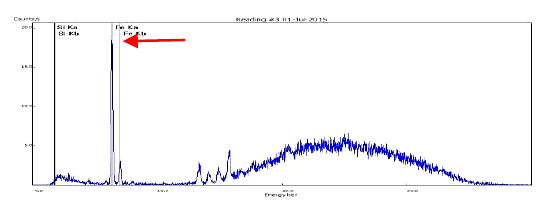
Table 3 .Component Analysis of Soil Surrounding the Burial